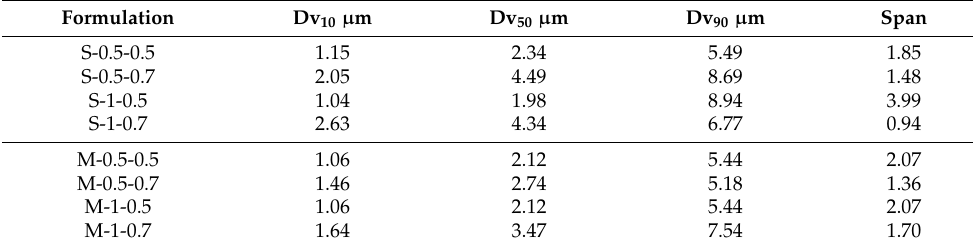
Table 3. Particle size distribution data of different excipient